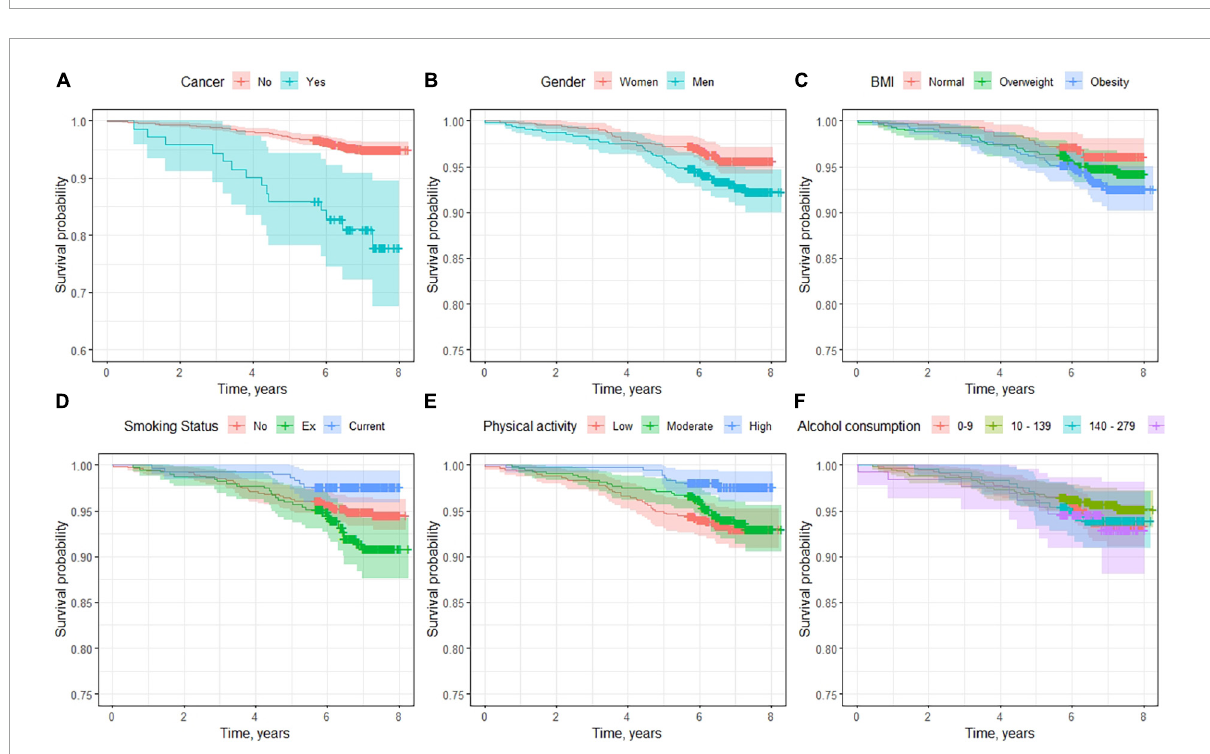
FIGURE2 Survival curves according to demographic factors and lifestyles. (A) Age, (B) sex differences, (C) body mass index classification, (D) smoking status, (E) physical activity, and (F) alcohol